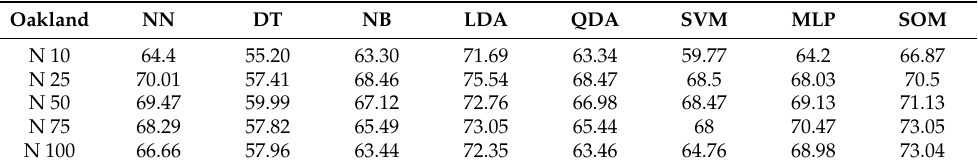
Table 7. Mean class recall values (in %) for different neighborhood definitions and different classifiers with the respective